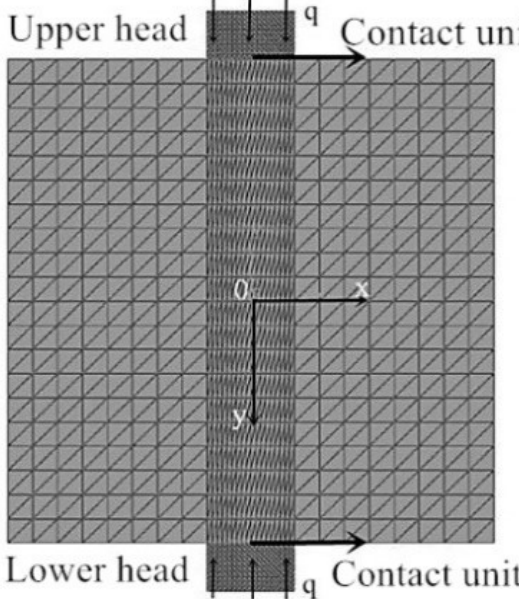
Figure 2. Finite element 2D model of XOY plane of the sample.